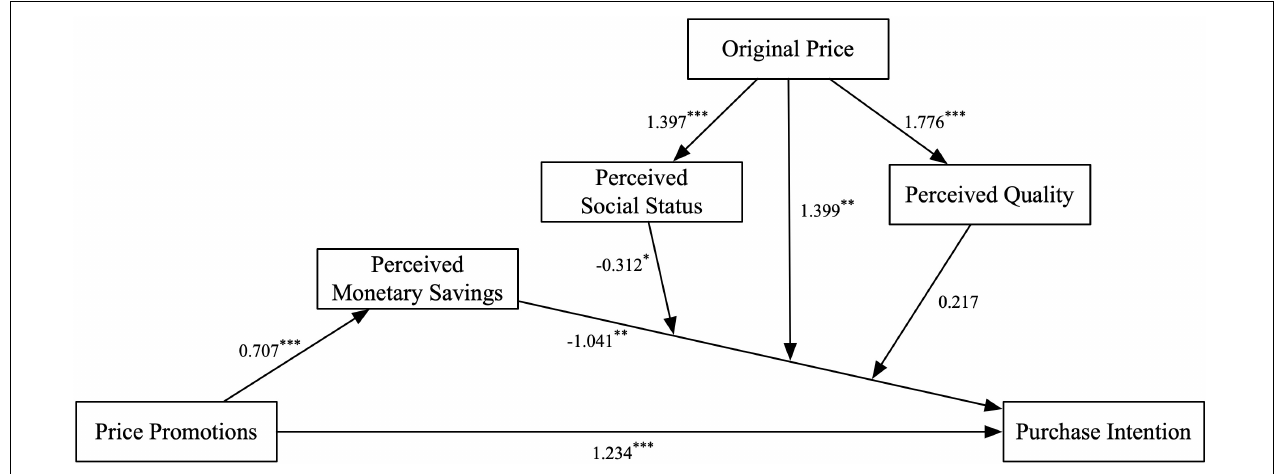
FIGURE 3 | The casual relationship model among variables and the results of moderation and mediation analyses. The figures near arrows suggest coefficients of independent variables. ∗ p < 0.1, ∗∗ p < 0.05, ∗∗∗ p < 0.001.